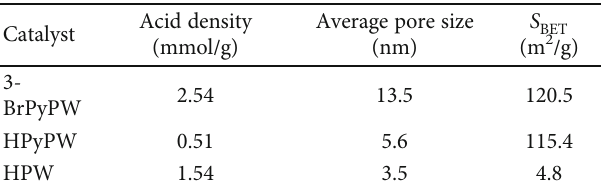
Figure 4: The N adsorption-desorption isotherms of 3-BrPyPW, 2 HPyPW, and HPW. Table 1: Acid density, pore size, and speci fi c surface area comparison of 3-BrPyPW, HPyPW, and HPW.